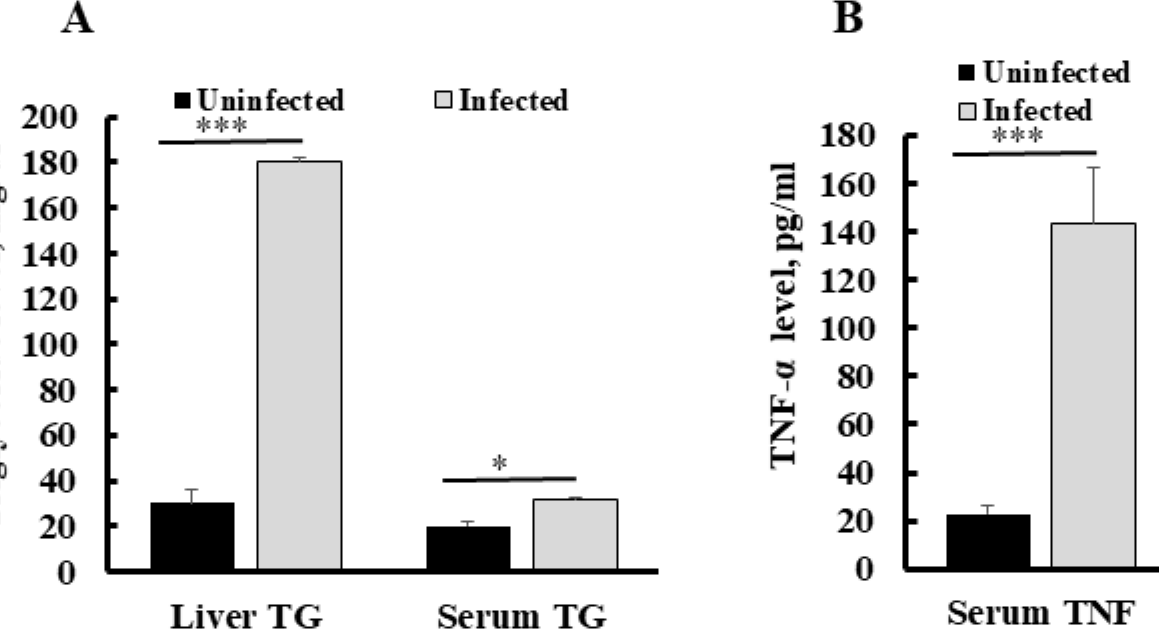
Figure 2. Concentration of serum TNF- α and liver triglyceride during Py MDR infection as compared to uninfected control ( A ) A significant increase in serum TNF- α level was observed in Py MDR infected mice, as compared to uninfected controls. ( B ) A significant increase in liver triglyceride was observed when Py MDR infected mice livers were compared with uninfected controls. p * < 0.05, P ** < 0.001, p *** < 0.0001.